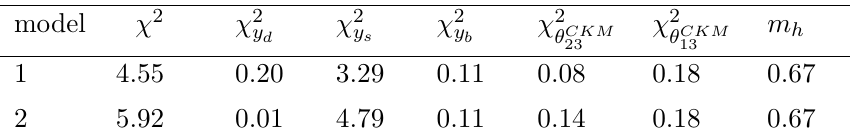
Table 5 . The total χ 2 and the dominant pulls χ 2 of models 1 and 2 of table 4. The subdominant pulls χ 2 which also gives the 2 -loop SM Higgs mass m retical uncertainty), while the rest are tree level DR values at M by SusyTCProton